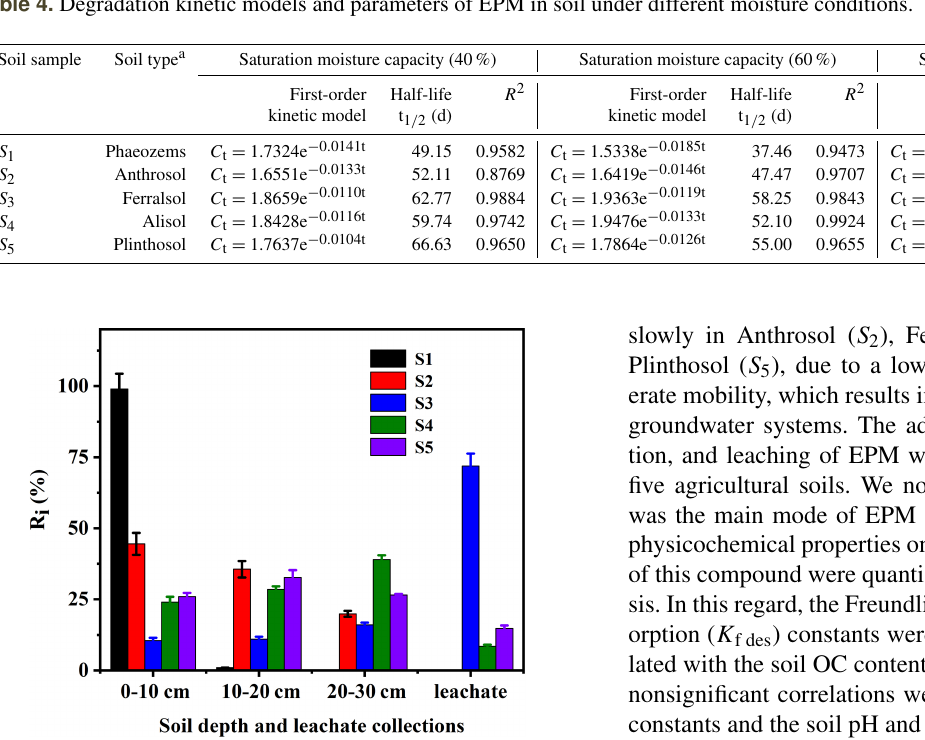
Table 4. Degradation kinetic models and parameters of EPM in soil under different moisture conditions.